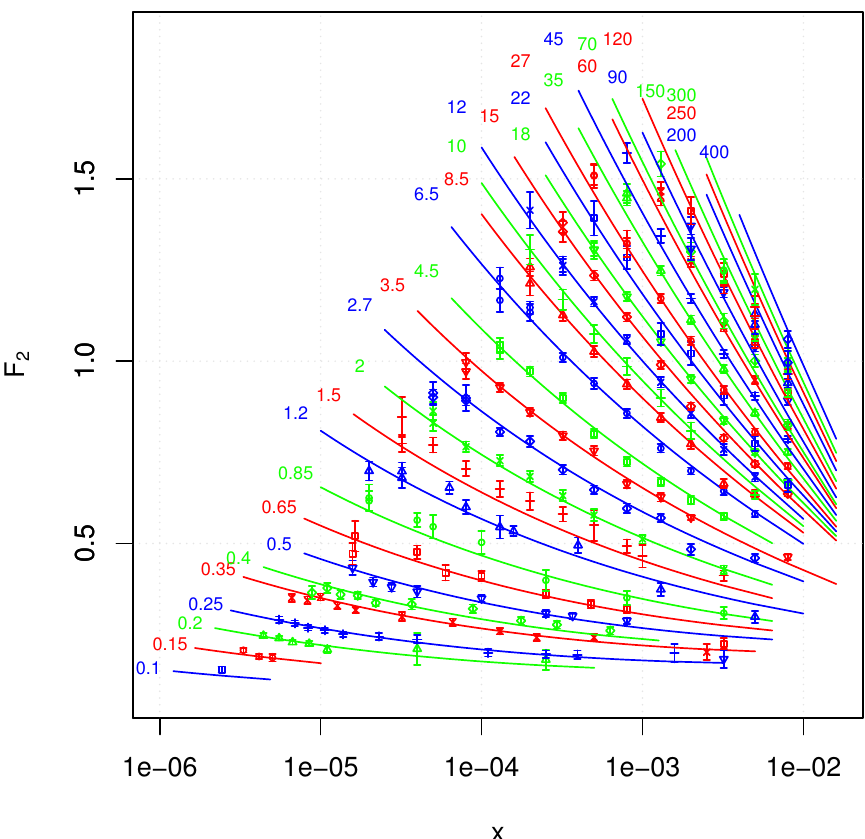
Figure 7 . Plot of the experimental F 2 data versus the prediction of our model. We cover a very large kinematical window with x < 0 : 01 and 0 : 1 < Q 2 < 400 in GeV 2 , in a total of 249 points. The (cid:31) 2 of this (cid:12)t is 1 : d:o:f: